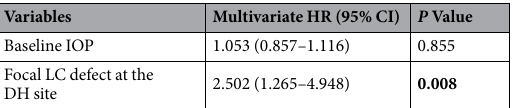
Table 4. Cox proportional hazards multivariate analysis of visual field progression in glaucoma patients with disc hemorrhage. CI, confidence interval; HR, hazard ratio; IOP, intraocular pressure; DH, disc hemorrhage; LC, lamina cribrosa. Variables with P < 0.10 in the univariate model were entered in a multivariate model. Factors with statistical significance are shown in bold.